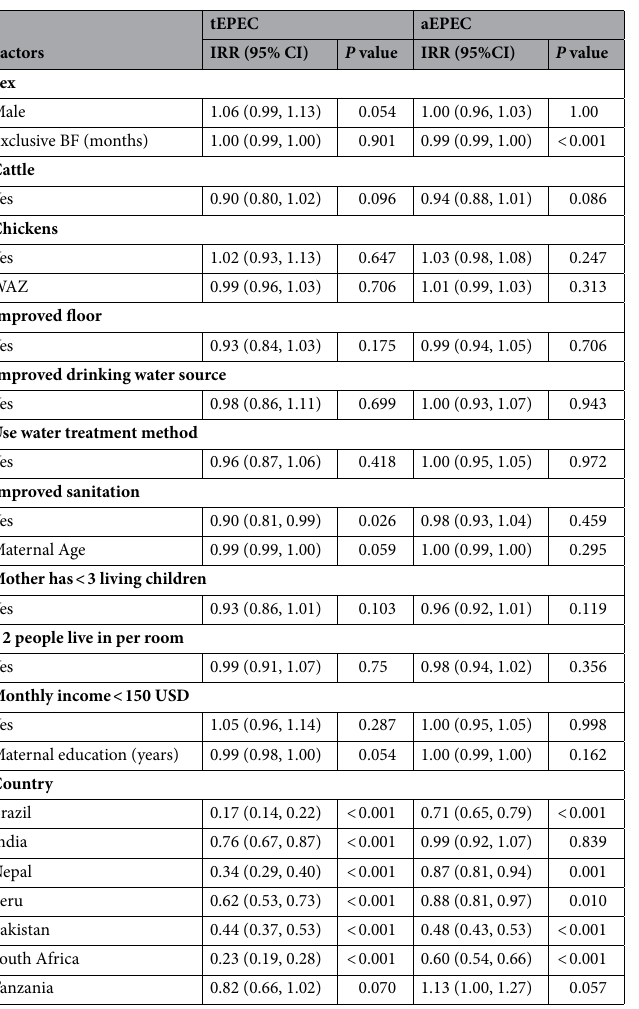
Table 2. Factors associated with infections by the two genomic subtypes of EPEC across each of the eight study sites (Bangladesh, India, Nepal, Pakistan, South Africa, Tanzania, Brazil, and Peru) from November 2009 to February 2012. Model: Poisson regression; IRR: Incidence rate ratio; aWAZ: Weight-for-age z score. Dependent variable: Number of infections during follow up (1–24 m). Offset: Log of the total number of follow up; alpha (α): dispersion parameter. Adjusted for the site and all variables included in the multivariable